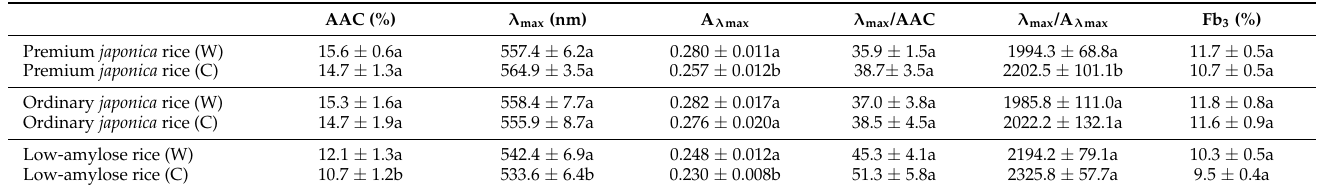
Table 2. Analysis of iodine absorption parameters of whole and chalky rice grains in 54 Japonica rice in 2020.